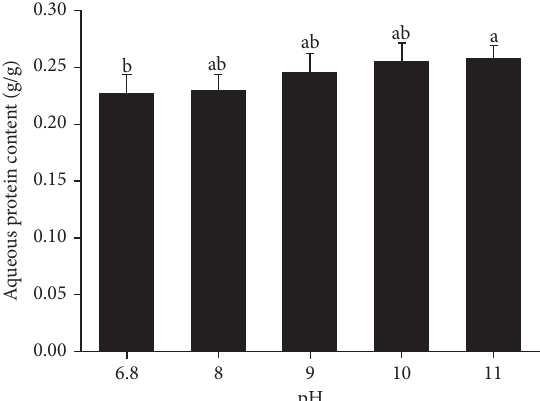
Figure 6: Effect of pH treatment of oil bodies on the aqueous phase protein content.